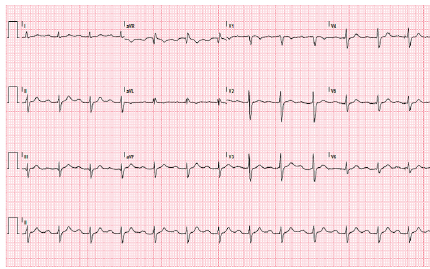
Figure 1: Patient’s ECG, showing a first degree heart block with an intraventricular conduction delay. PR interval: 302 ms, QRS duration: 144 ms, and ventricular rate: 76 beats per